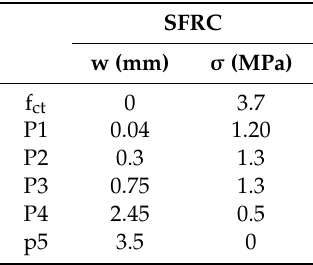
Table 5. Parameters of steel fibre-reinforced concrete (SFRC) softening